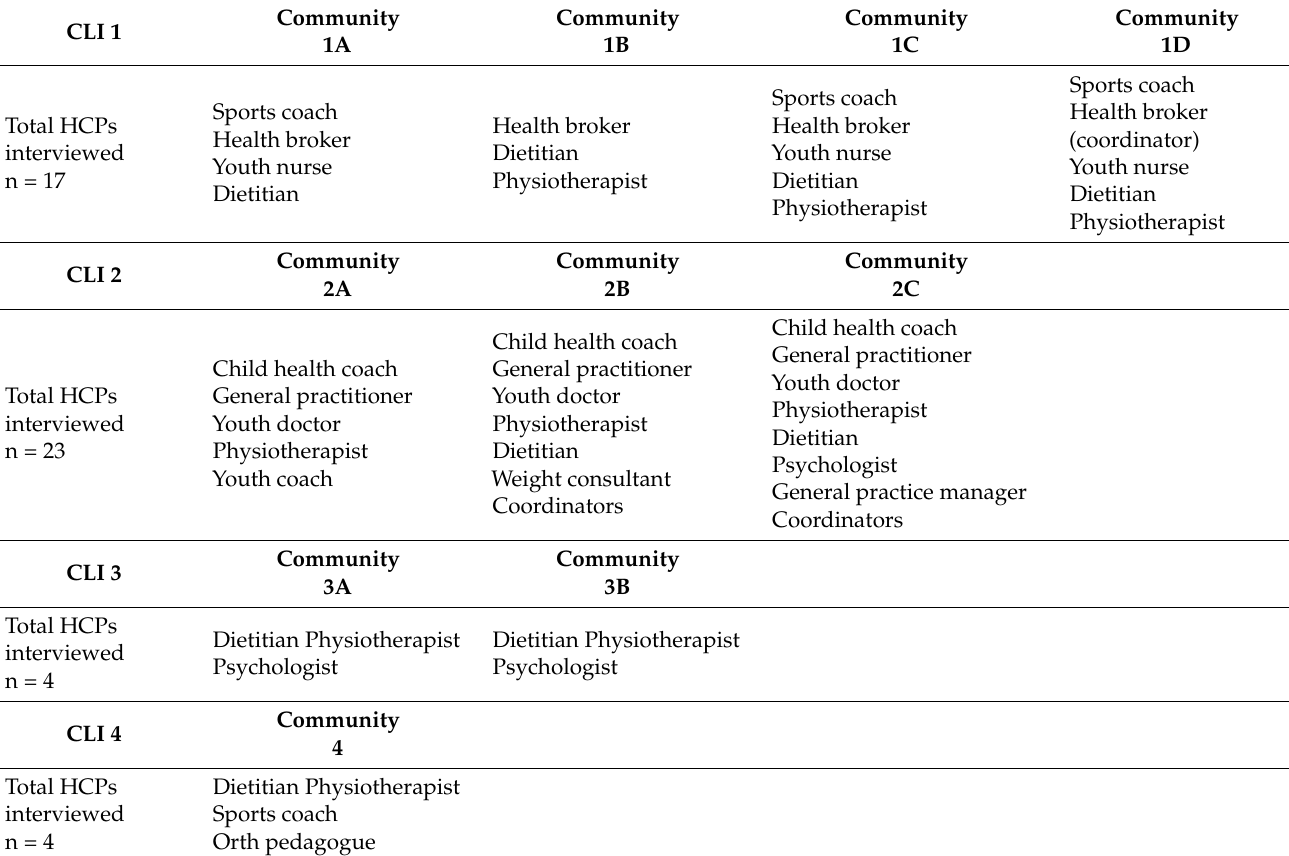
Table 2. Interviewed HCPs. An overview of the interviewed HCPs per CLI and